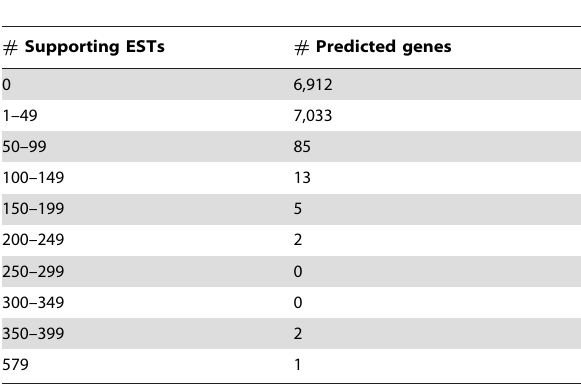
Table 2. Summary of the predicted genes supported by